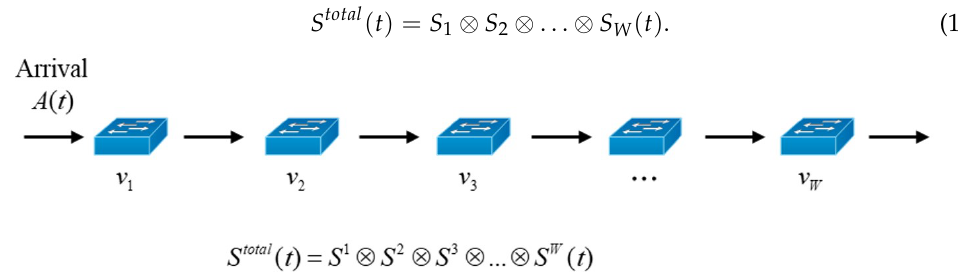
Figure 4. Traffic process for W traversed